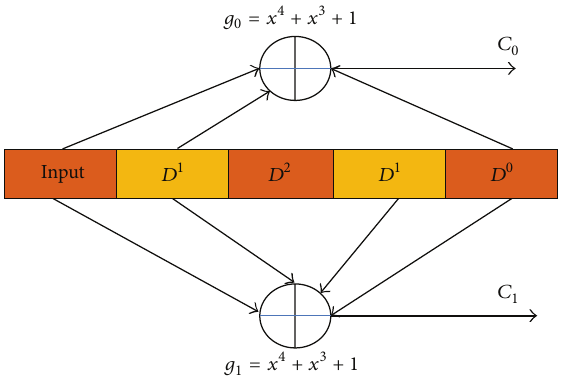
Figure 1: Conventional convolution encoder architecture for GSM- 900 standard with generator polynomials 𝑔 0 (𝑥) = (31) 8 and 𝑔 1 (𝑥) = (33) 8